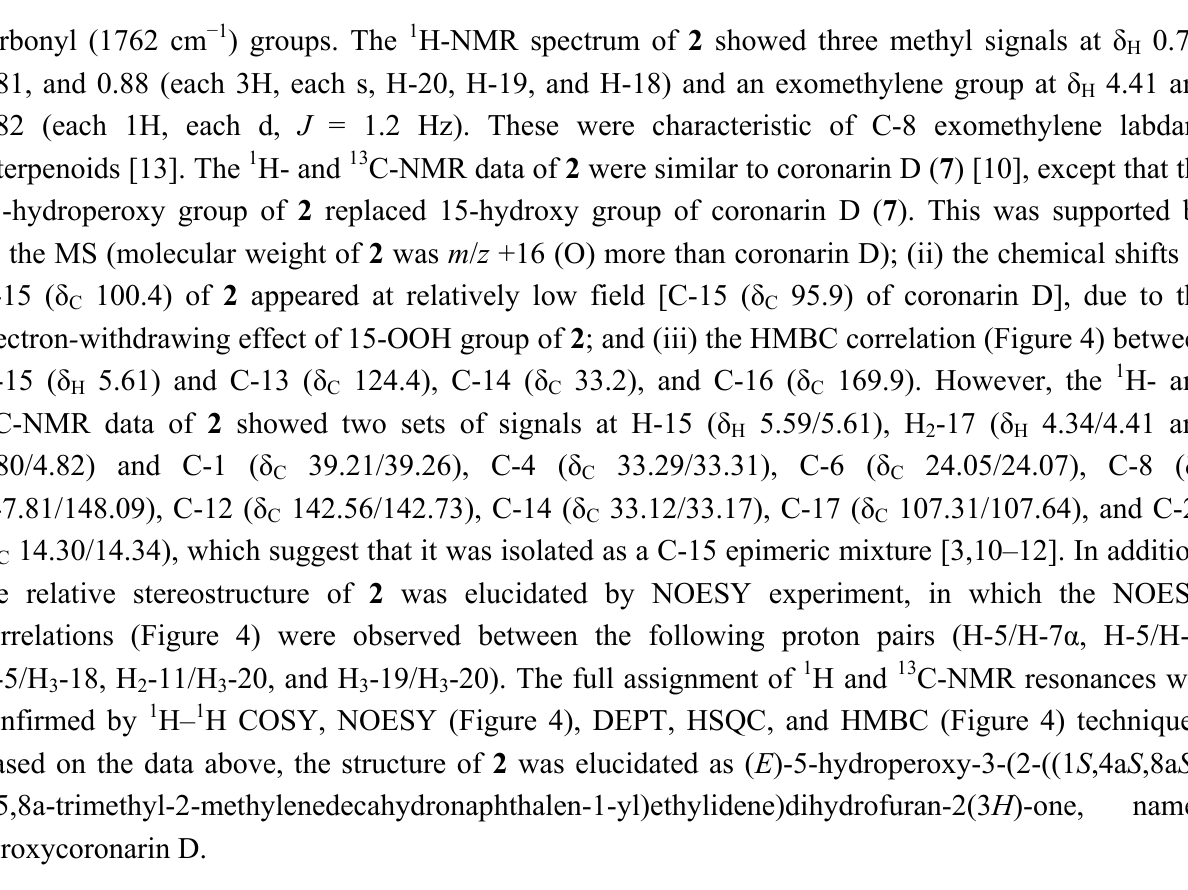
Figure 4. Key NOESY (4a) and HMBC (4b) correlations of 2